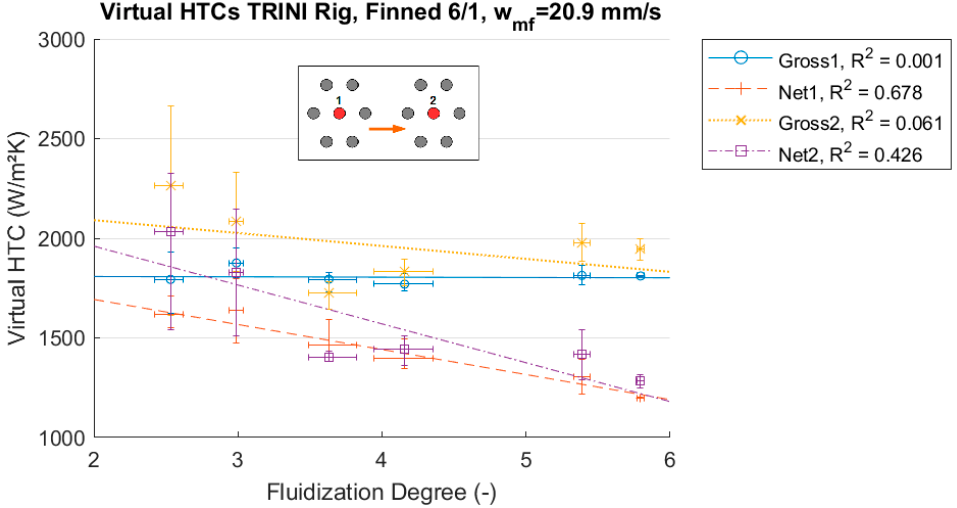
Figure 18. Results of helically finned tubes, pitch 6 mm, fin thickness 1 mm, TRINI test rig, 146 µm particles. Indices 1 and 2 refer to the different heated tubes.